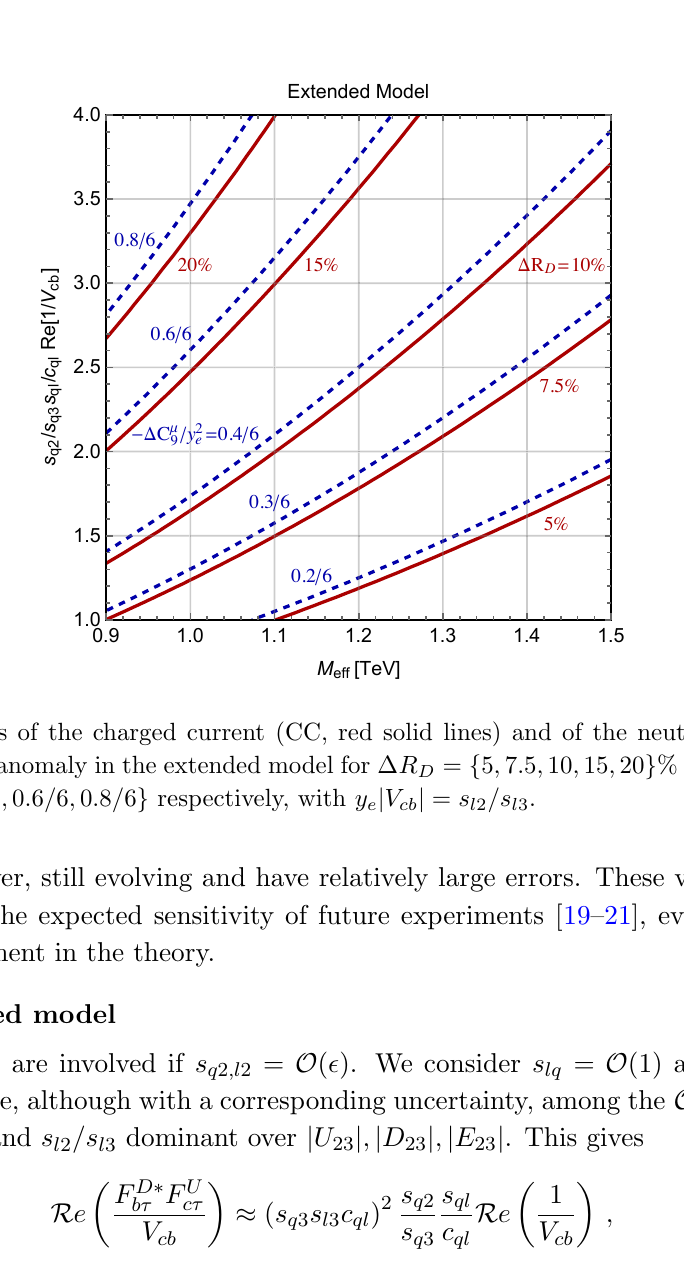
respectively, with y }